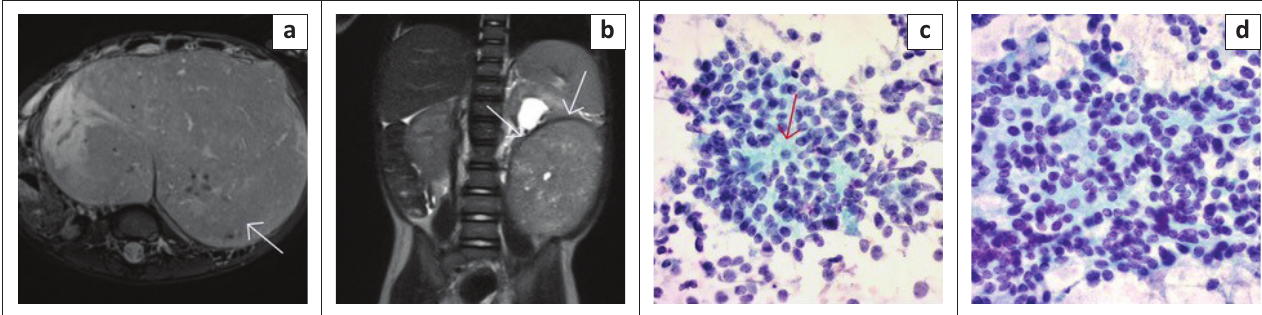
FIGURE 3: (a) Axial T2W image demonstrated a massive heterogeneous intra-abdominal mass (white arrow), which appeared to arise from the retroperitoneum, and crossed the midline to the contralateral side. Exit foramina were, however, intact. (b) Coronal T2W image of the same patient, demonstrated a left renal claw sign (white arrows), in keeping with renal origin. This claw sign was initially missed which resulted in an incorrect primary radiological diagnosis of neuroblastoma instead of nephroblastoma. (c & d) Cytology shows small blue cells with round-oval nuclei with a pinpoint nucleolus lying associated with a green fibrillar matrix (red arrow) which is neuropil. This was interpreted as neuroblastoma as the only component present on the FNAB (Papanicolaou stain, 40×).